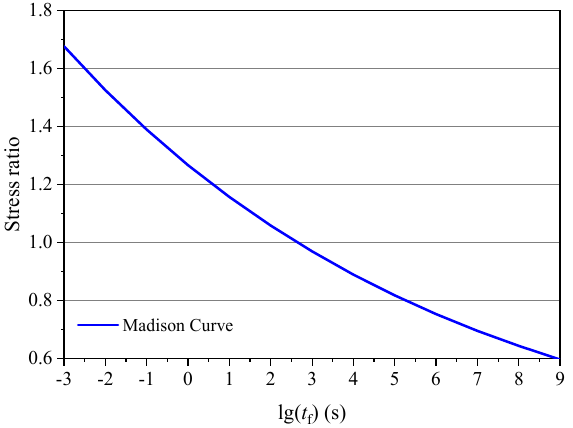
Figure 1. Madison Curve.